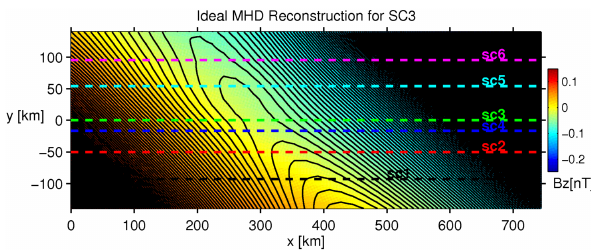
Figure 10. Ideal MHD reconstruction map of the magnetic field lines (black solid lines) 614 Fig. 10. Ideal MHD reconstruction map of the magnetic field lines with axial field in color, based on spacecraft 3. The format is the same as in Figure 5. 615 (black solid lines) with axial field B z in color, based on spacecraft z B